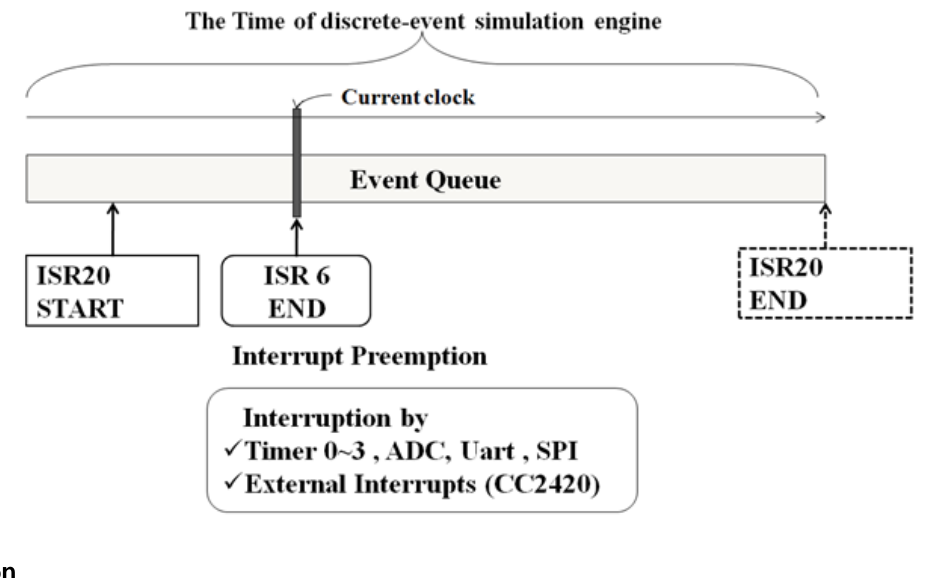
Figure 6. An interrupt preemption scenario in optimistic